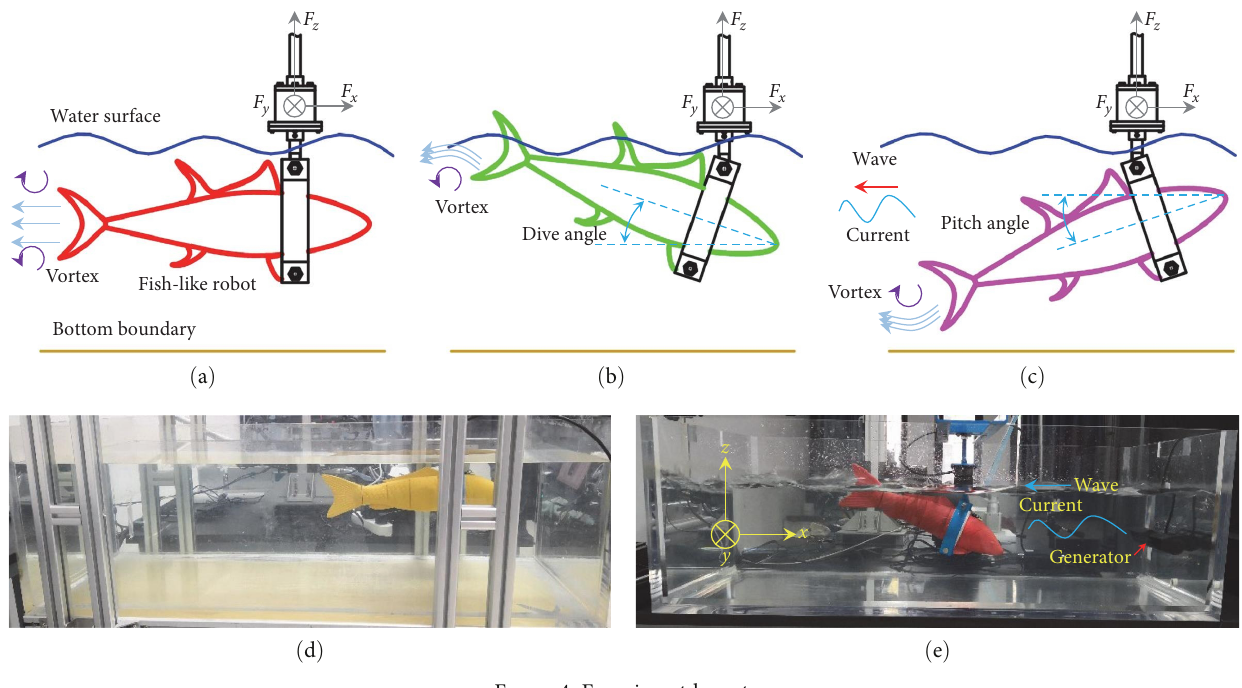
F IGURE 4: Experiment